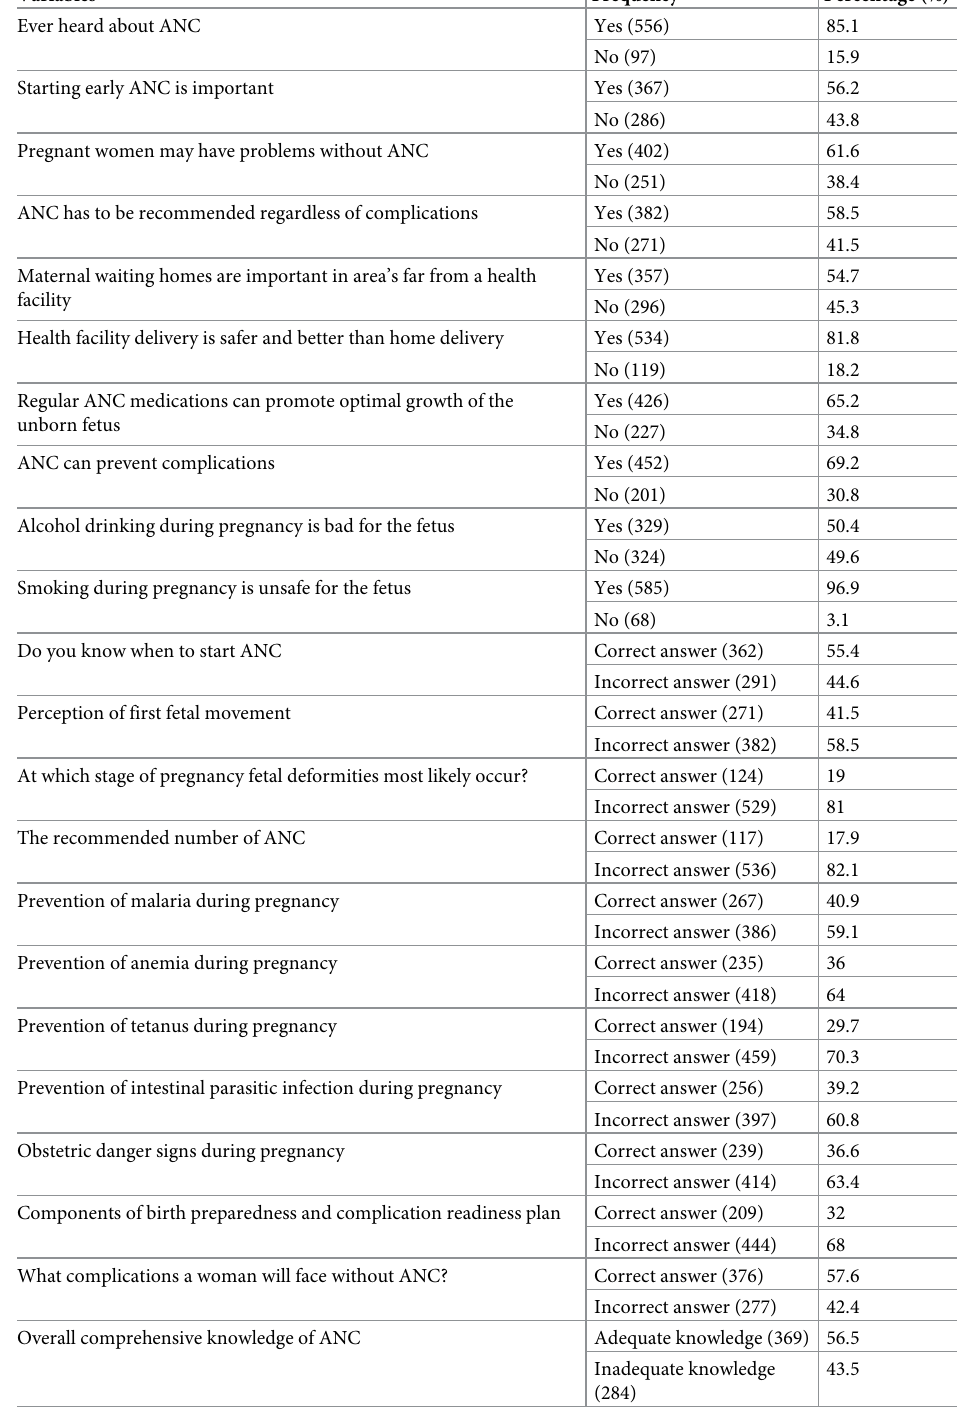
Table 3. Comprehensive knowledge of antenatal care among women delivered at home in rural Sehala Seyemit district, northern Ethiopia, 2020 (n =